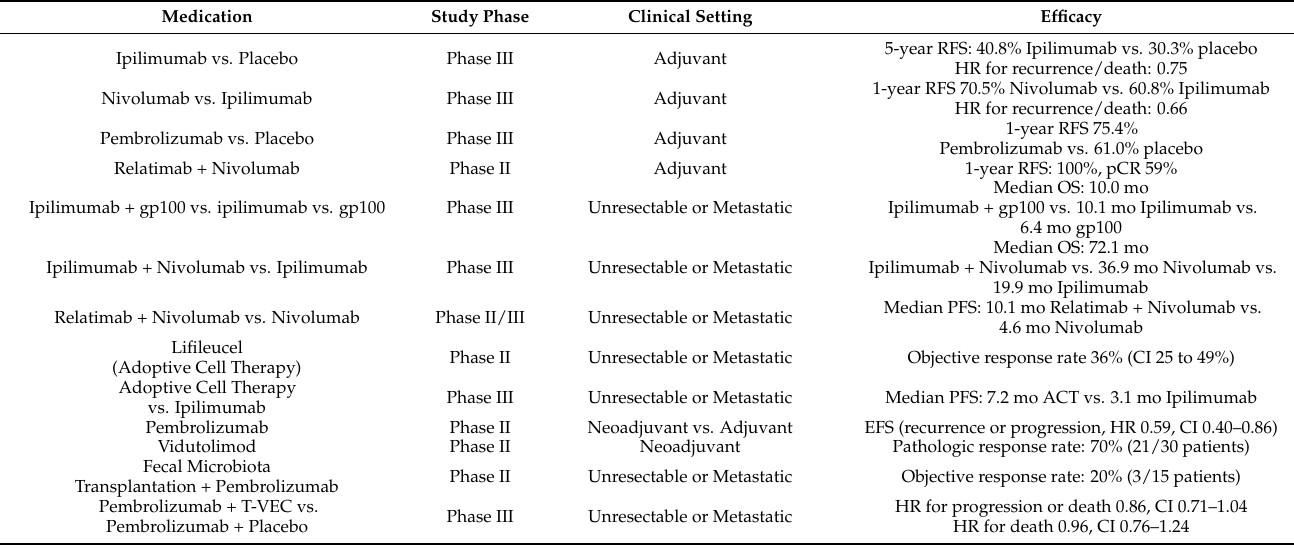
Table 1. Clinical Trials of Immunotherapy